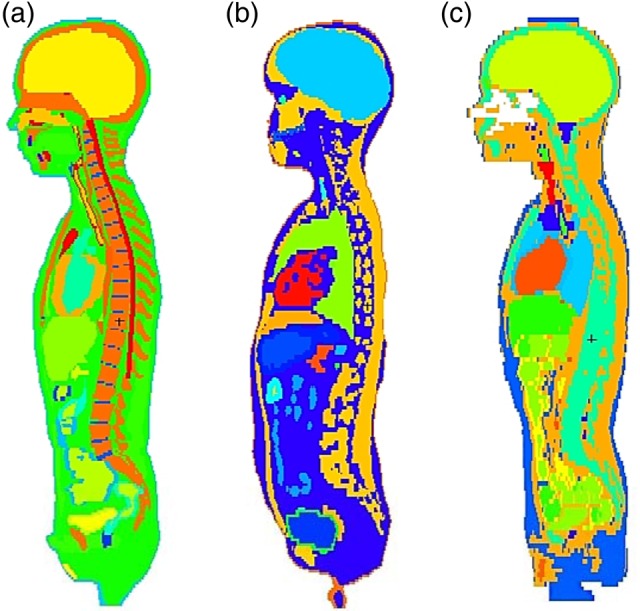
The sagittal views of pediatric phantoms: (a) Iranian 11-year-old male phantom, (b) Iranian 11-year-old female phantom and (c) UF 11-year old male phantom.